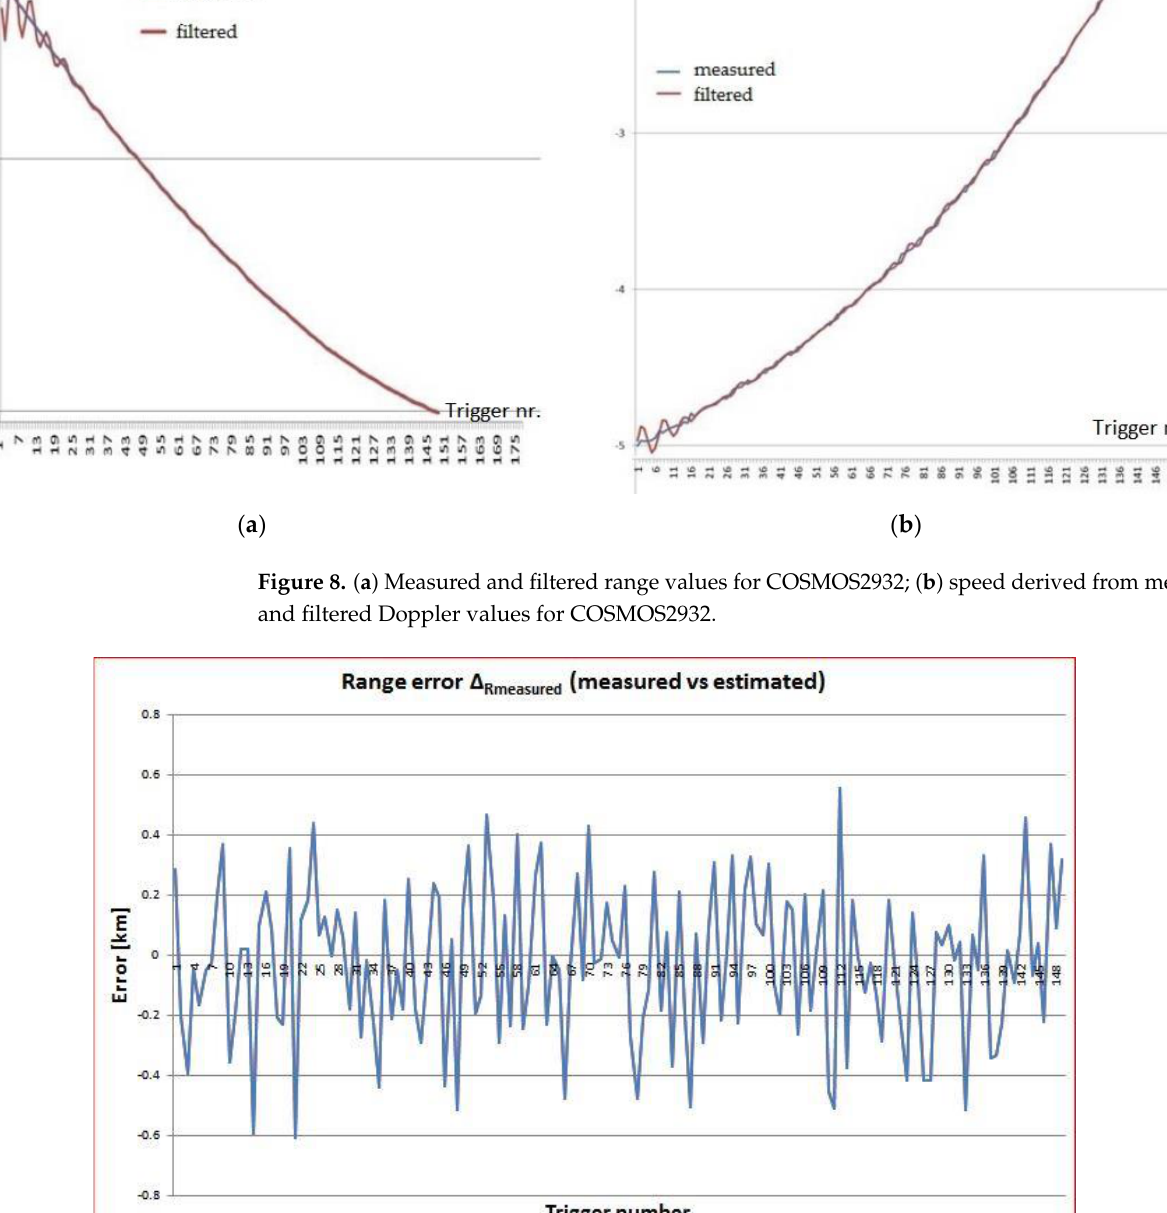
Figure 9. Difference between the measured and the TLE-computed values for range as a function of trigger number (time) for COSMOS2932.